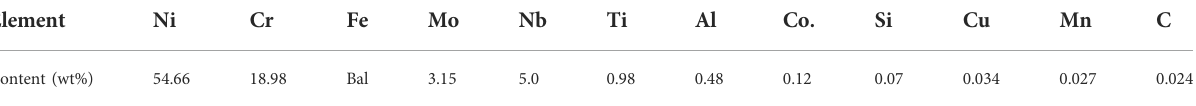
TABLE 3 Nominal chemical composition of the gas atomized Inconel 718 powder.